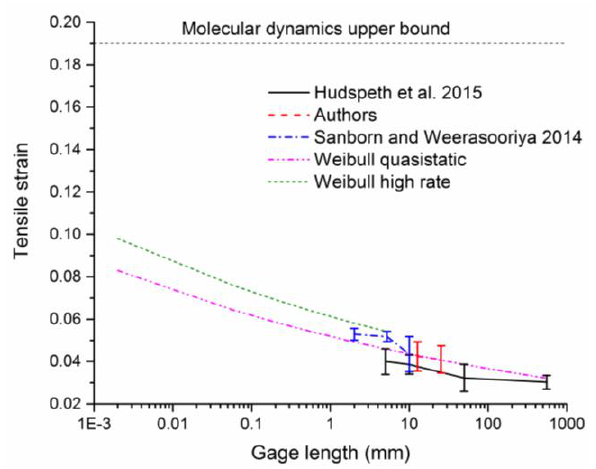
Figure 11. Single Kevlar KM2 fiber tensile failure strain as a function of gage length.